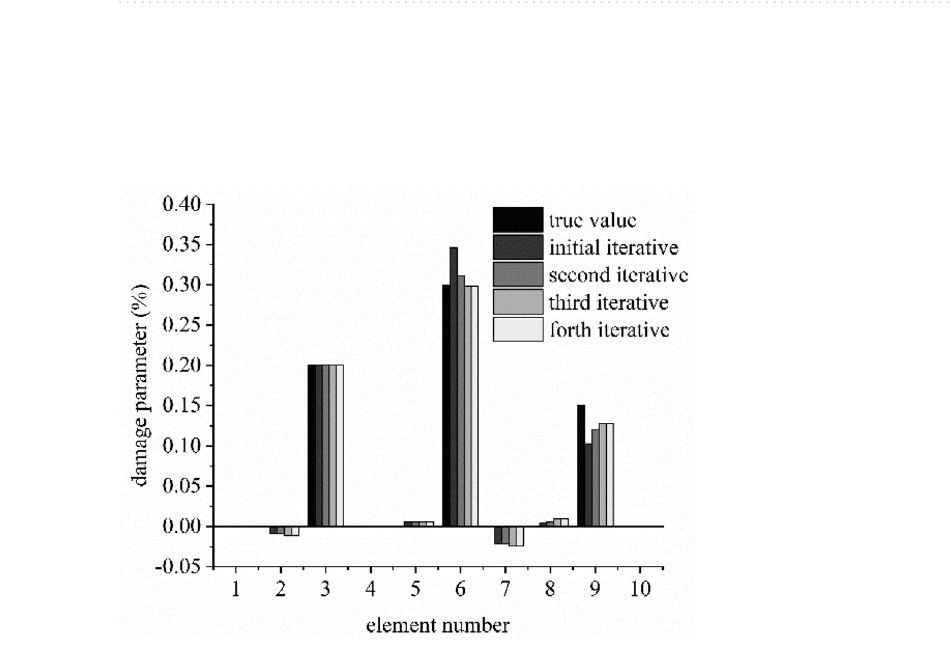
Figure 6. Displacement response tracking diagram of element No.6.